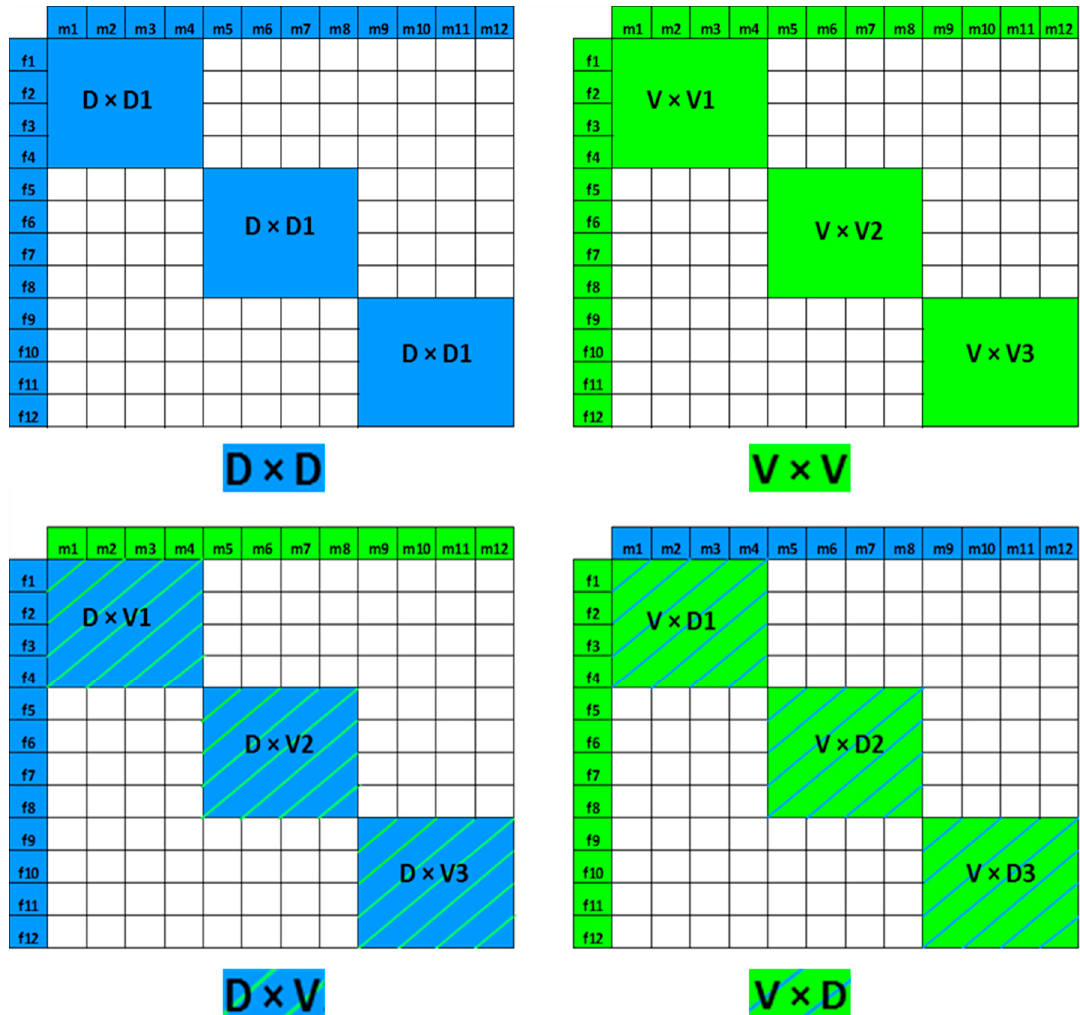
Figure 1. The cross-breeding of sterlet, Acipenser ruthenus , using 12 males and 12 females from Danube (D, blue) and Volga (V, green) populations, establishing three groups of purebred Danube and Volga (D1–D3, V1–V2) and six groups of reciprocal hybrids.